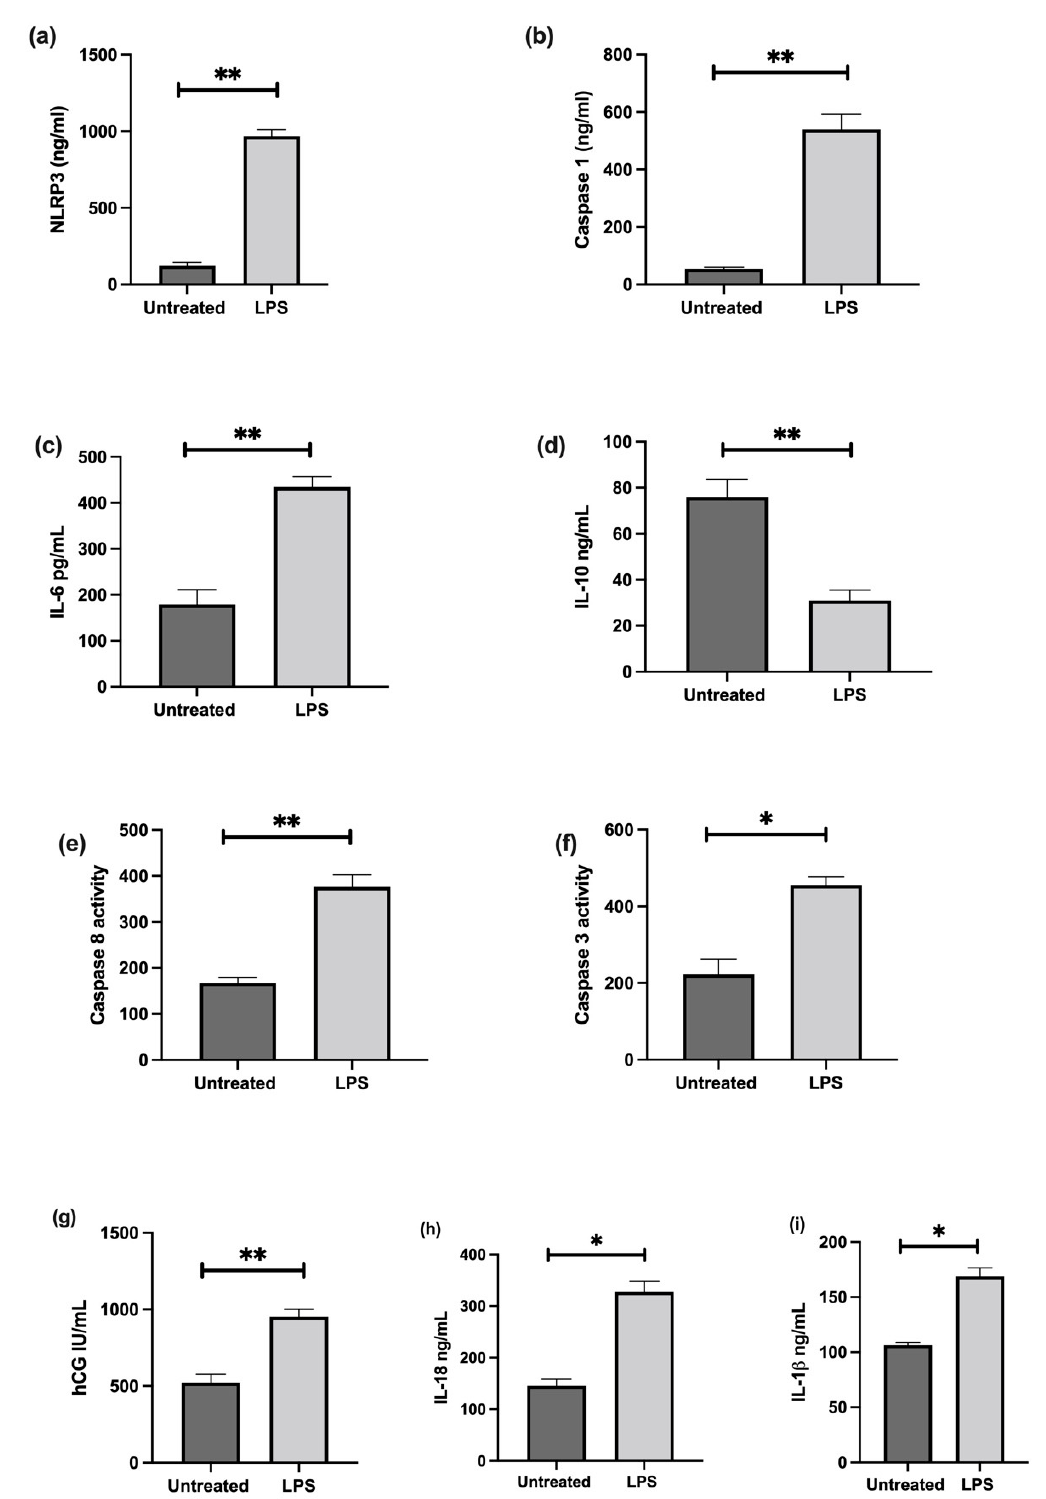
Figure 8. Effect of LPS on protein expression of NLRP3, caspase-1, pro- and anti-inflammatory cytokines, and trophoblast differentiation marker; and activity of apoptosis markers in BeWo cells. LPS treatment increases protein concentrations of ( a ) NLRP3, ( b ) caspase-1, ( c ) IL-6, ( i ) IL-1 β , ( h ) IL-18, and ( g ) β hCG, and increases activity of ( f ) caspase-3 and ( e ) 8; but decreases ( d ) IL-10 protein expression when compared to untreated cells. Significant differences are denoted by * p < 0.05; ** p < 0.005.